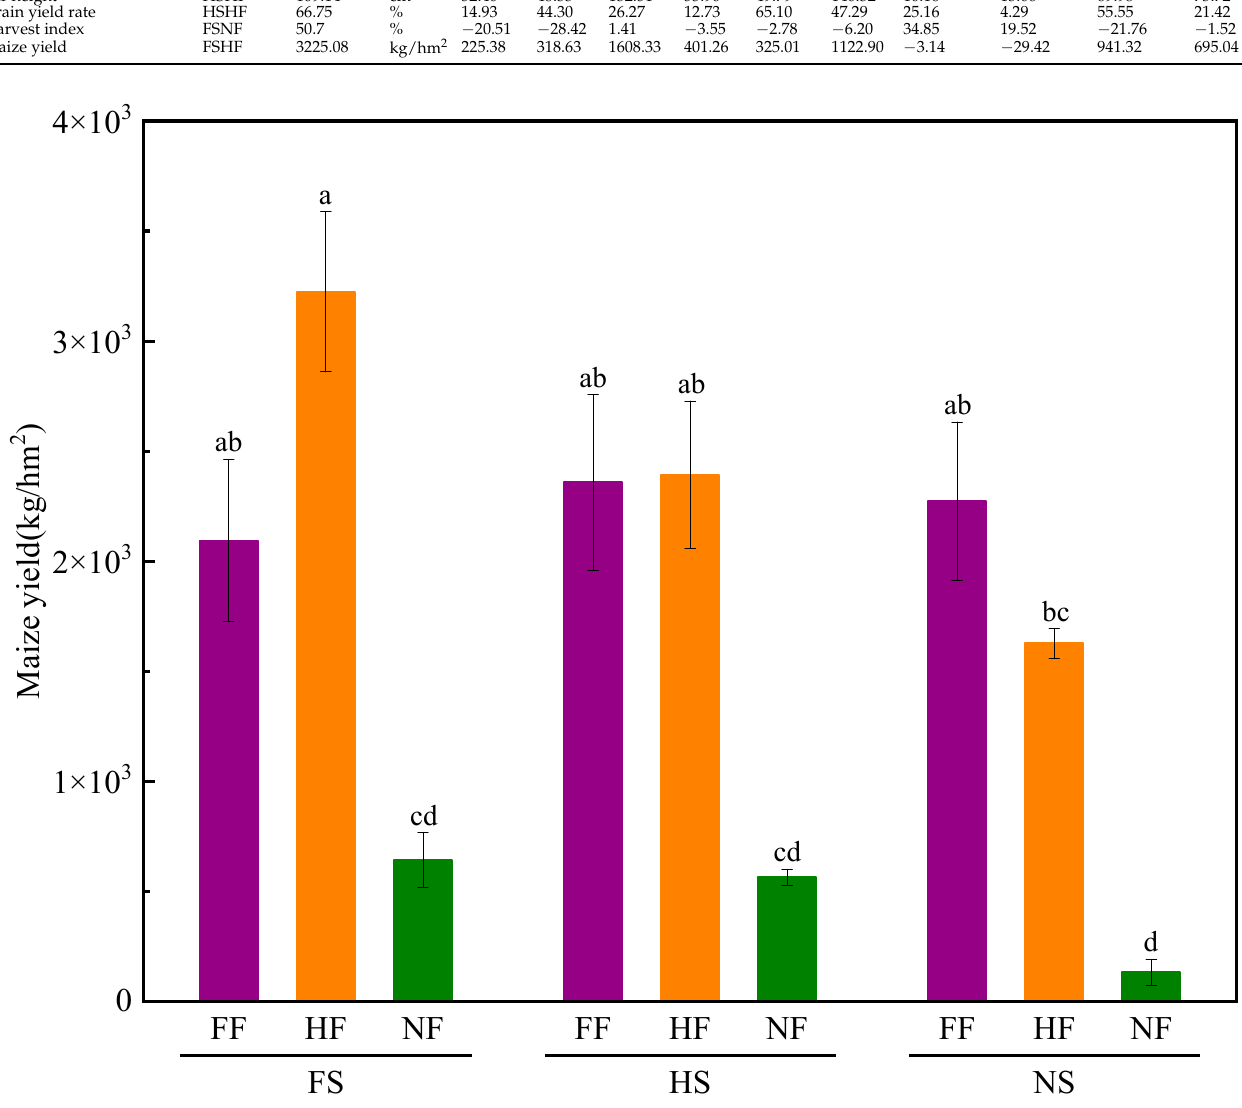
Figure 6. Effects of SLR and FR on maize yield. Note: Bars represent means ± standard deviation ( n = 3) with different letters indicating significant differences based on LSD ( p ≤ 0.05). SLR, sugarcane leaf return; FR, fertilizer reduction.